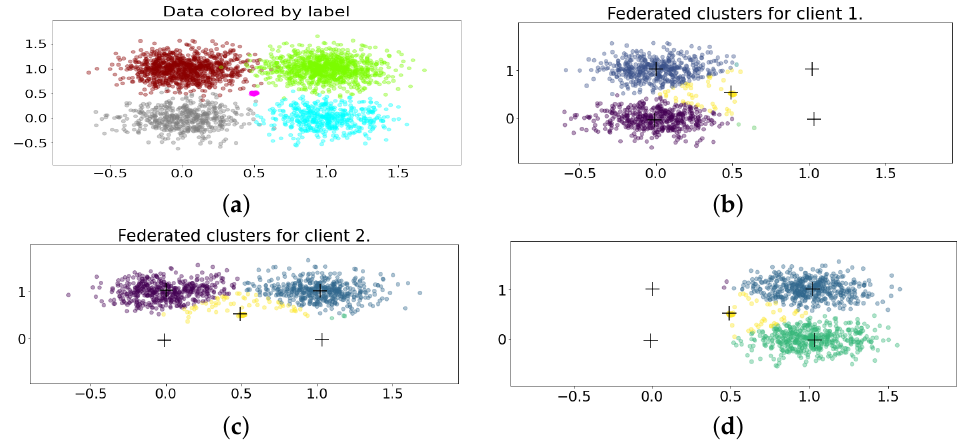
Figure 1. Motivational example. ( a ) The centralized dataset. Colors correspond to ground truth partitions. ( b – d ) The distributed dataset. Crosses denote the clustering result of the federated clustering framework. Original cluster centers are recovered even though no client alone was able to do